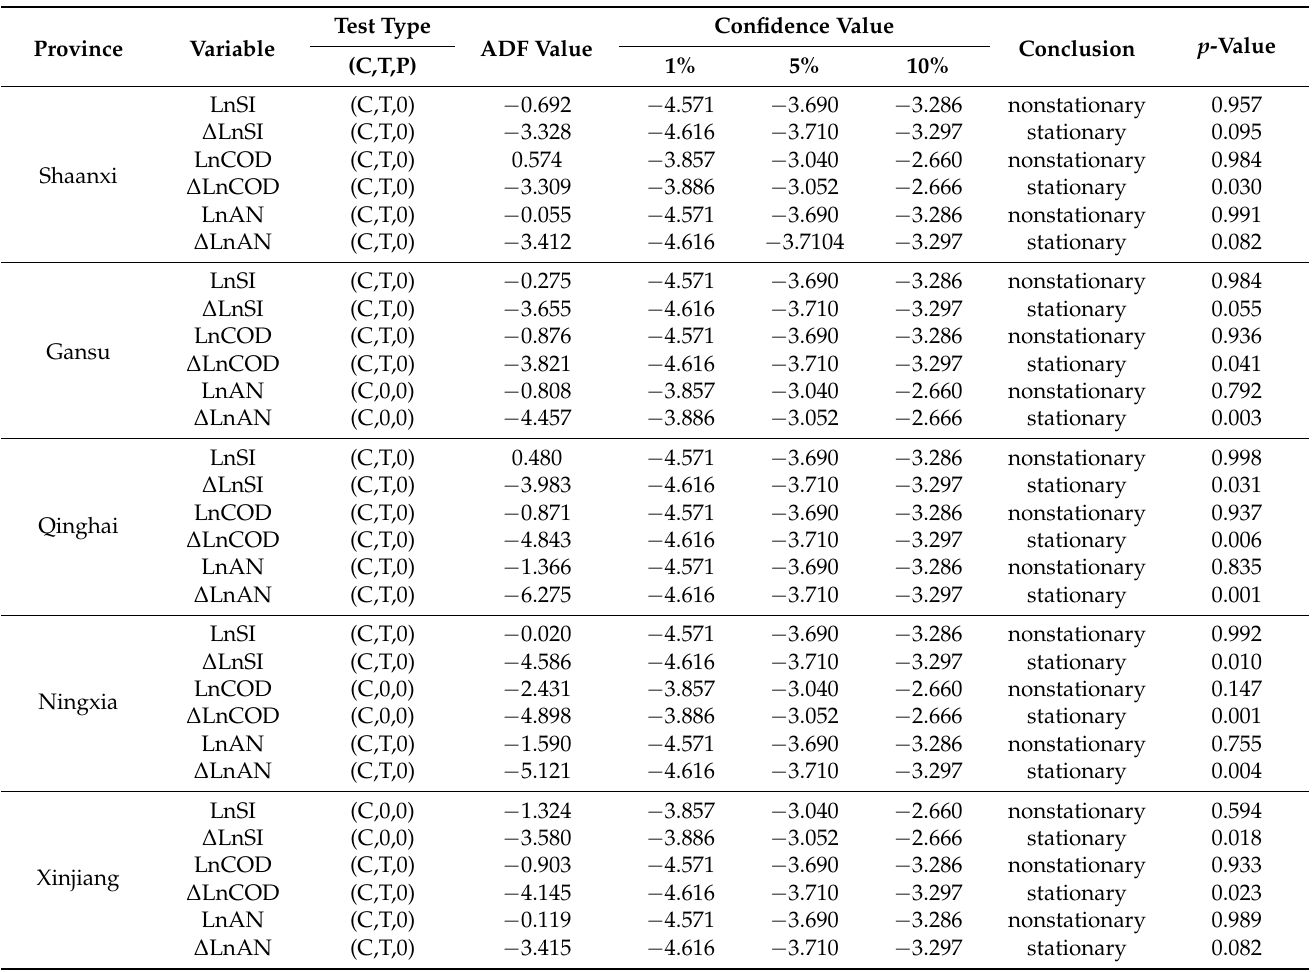
Table 1. Results of the unit root